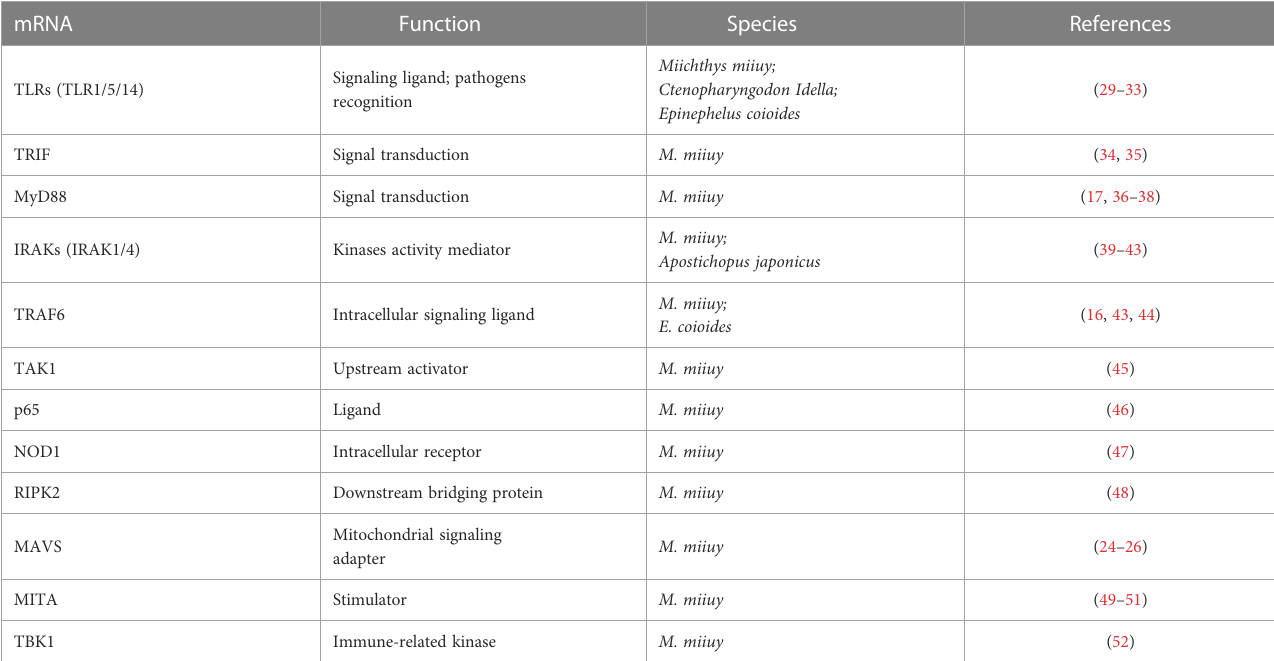
TABLE 2 Summary of identi fi ed mRNAs associated with the nuclear factor-kappa B (NF- k B) pathway in aquatic animals. mRNA Function